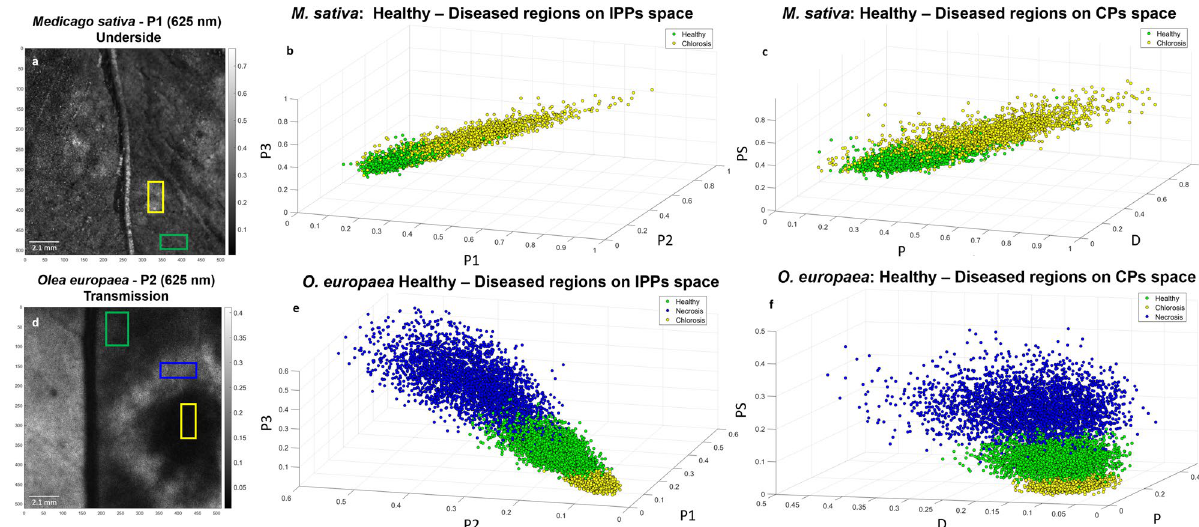
Figure 4. Scatter data plots of healthy and diseased tissue regions of Medicago sativa and Olea europaea . ( a ) Visual indicative for healthy (green) and chlorotic (yellow) tissue selected region of interest (ROI) for M. sativa , ( b ) corresponding IPPs space ( P 1 , P 2 , P 3 ) for healthy and chlorotic data clouds representation, ( c ) components of purity ( P , D , P S ) space for healthy and chlorotic data clouds representation, ( d ) visual indicative for selected healthy (green), chlorotic (yellow) and necrotic (dark blue) tissue ROIs for O. europaea , ( e ) corresponding IPPs space ( P 1 , P 2 , P 3 ) for healthy, chlorotic and necrotic data clouds representation and ( f ) components of purity ( P , D , P S ) space for healthy, chlorotic and necrotic data clouds